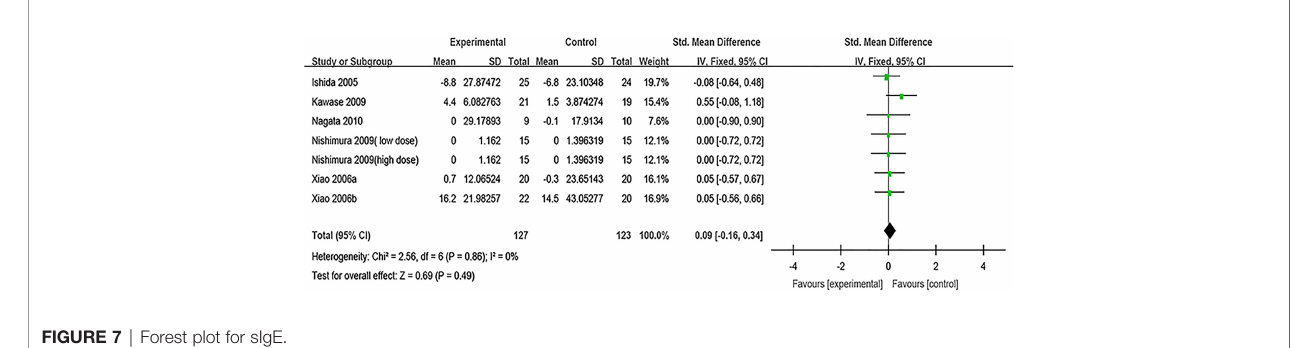
FIGURE 7 | Forest plot for sIgE.